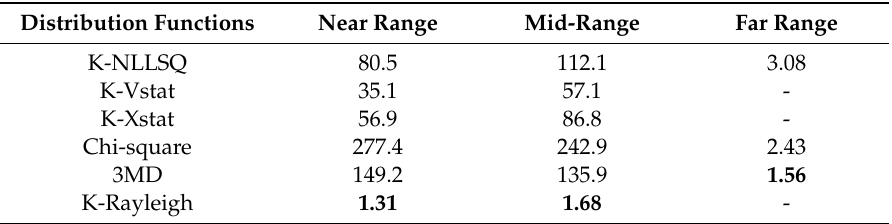
Table 5. False alarm rate errors for linearly acquired data. The values in the table are the ratio between the estimated actual false alarm rate and the set false alarm rate of 10 − 6 .